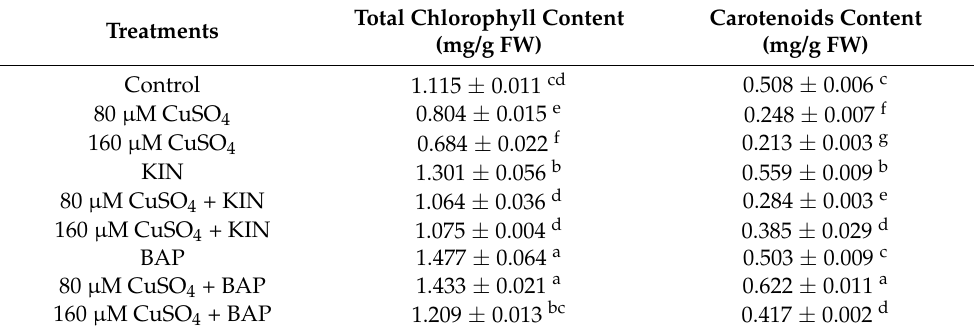
Table 2. Total chlorophyll and carotenoid contents in the cotyledonary leaves of R. communis after 6 day of exposure to CuSO 4 (80 and 160 µ M) and cytokinin (KIN and BAP) treatments in Hoagland’s nutrient medium. Values are the mean ± SE of three independent experiments. Different alphabetical letters indicate significant differences between treatments according to one-way ANOVA (Duncan’s test p ≤